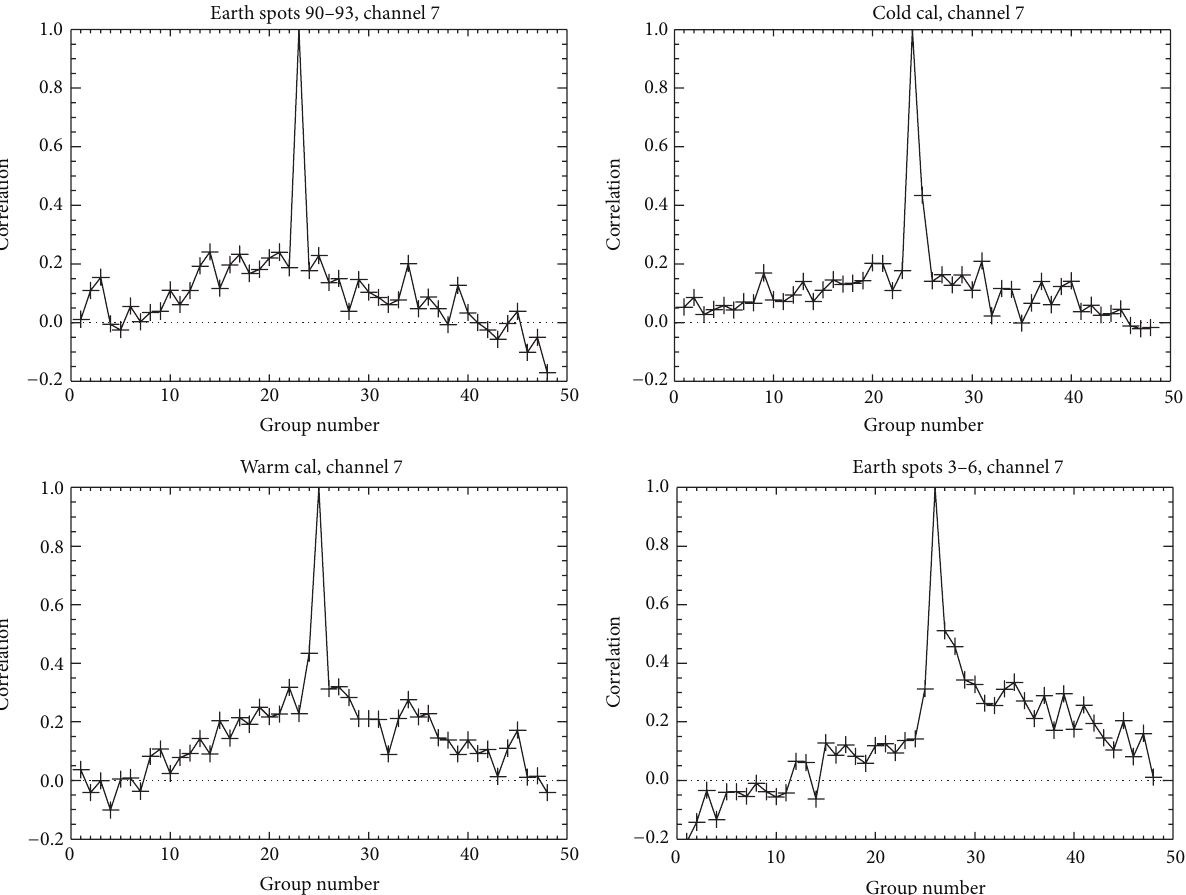
Figure 6: Correlations between groups of 4 pixels for ATMS channel 7. Groups 1–23 are earth views, 24 is cold cal, 25 is warm cal, and 26–48 are earth views of the next